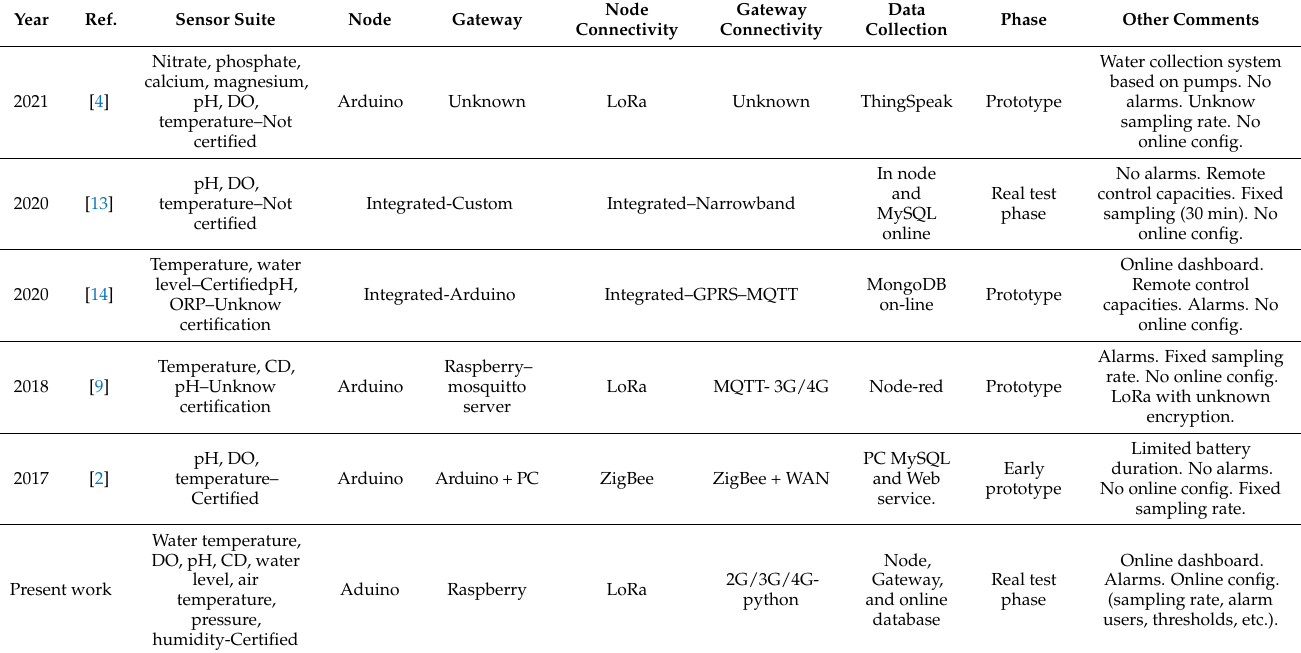
Table 1. Summary table with relevant examples of water quality monitoring networks and their main